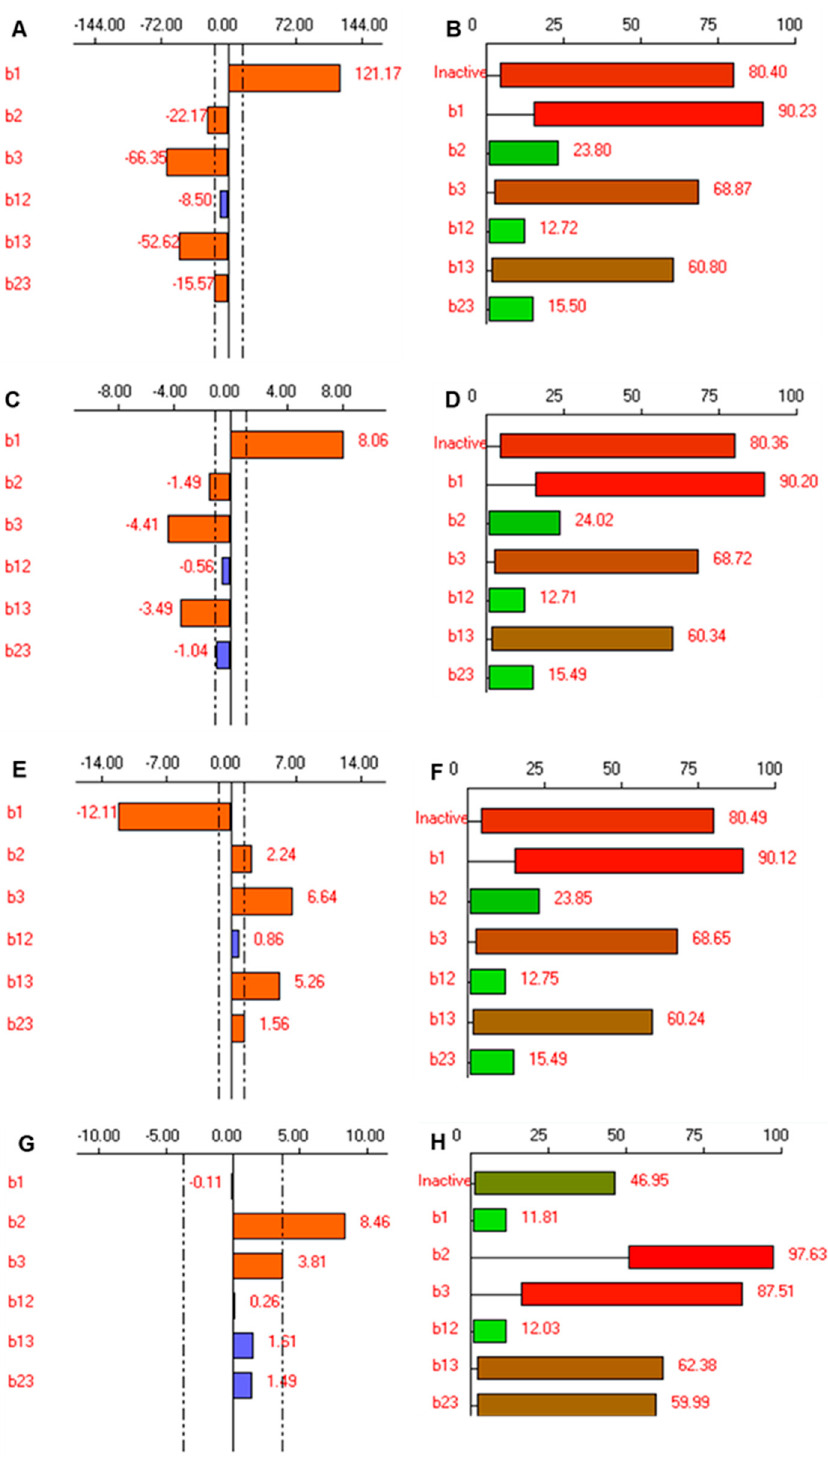
Figure 3. Lenth’s graphical analysis ( A , C , E , G ) and Bayesian analysis of the coefficients ( B , D , F , H ) indicate the probability of each CFA’s (X) activity for all the considered CQAs (Y), ( B , D , F , G) for Y 1 (particle size), ( D ) Y 2 (relative deformability), ( F ) Y 3 (transmittance) and ( H ) Y 4 (dissolution efficiency), respectively.